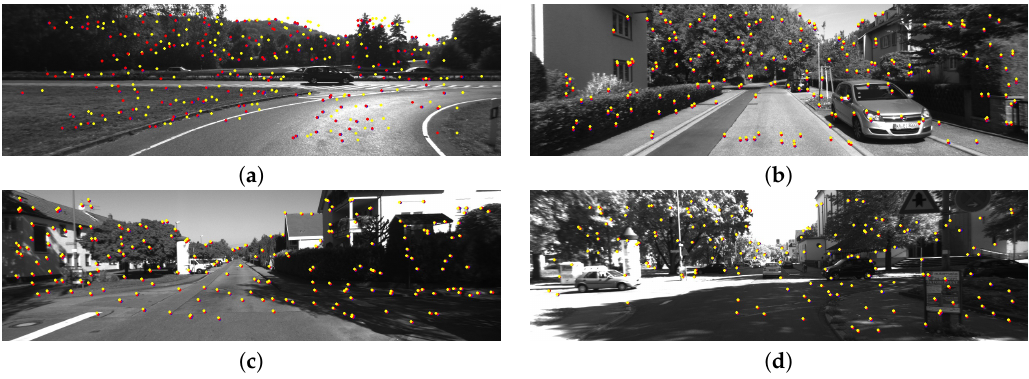
Figure 10. Feature points reprojection before and after hypothesis aggregation in four KITTI dataset sequences. Red points are reprojection from the ground truth motion, yellow and blue points are before and after hypotheses’ aggregation, respectively. ( a ) KITTI 01; ( b ) KITTI 03; ( c ) KITTI 05; ( d ) KITTI 08.